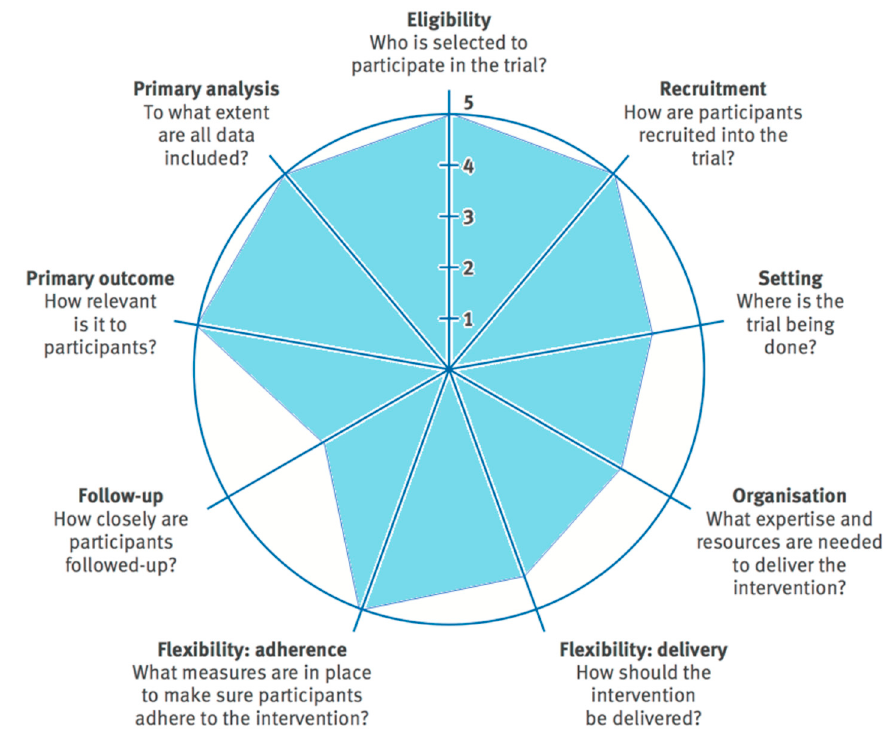
Figure A1. Pragmatic Explanatory Continuum Indicator Summary-2 (PRECIS-2) wheel for this pragmatic trial. For each domain higher scores indicate a more pragmatic approach and lower scores a more explanatory approach.